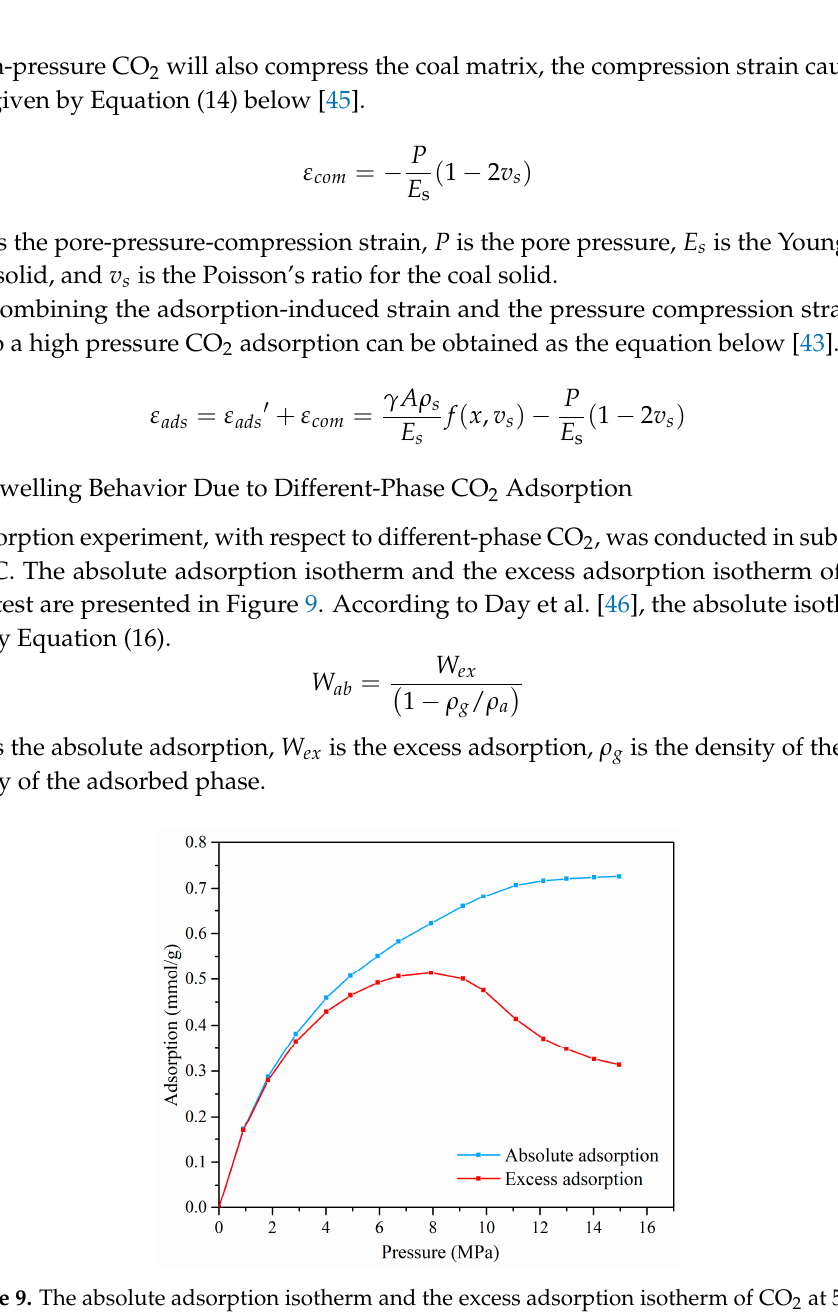
Figure 10. The adsorption-induced strain versus the pore pressure at 50 °C.